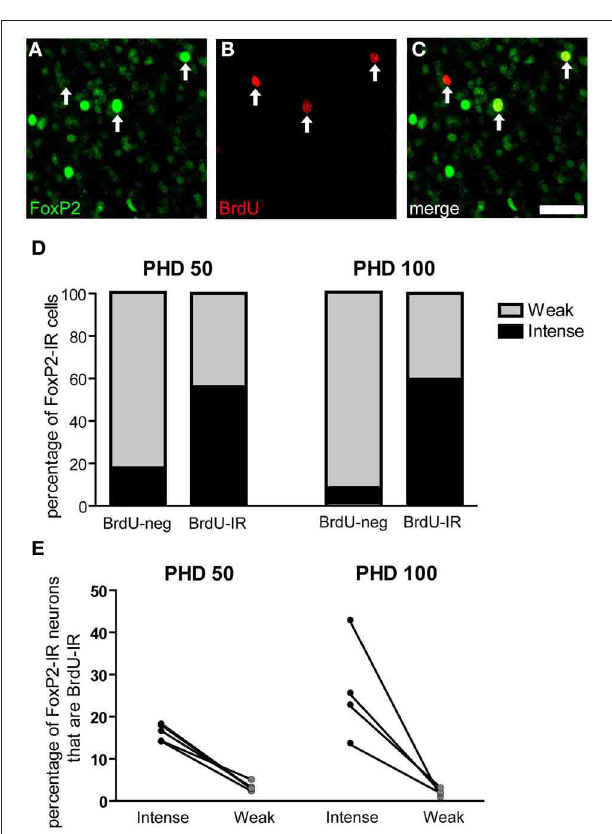
FIGURE 8 | Three-week old FoxP2-IR neurons are more likely to be intensely-stained than weakly-stained. (A–C) Photomicrographs depicting fluorescently-labeled FoxP2-IR cells (green) and BrdU-IR cells (red). Arrows indicate cells that are double labeled. Note that the cell on the left is weakly-stained for FoxP2 and the remaining two cells are intensely-stained for FoxP2. Scale bar = 50 µ m (D) In post-hatch day 50 and 100 males, BrdU-IR cells birth-dated 21 days prior to sacrifice were ∼ 60% intensely-stained for FoxP2, whereas BrdU-negative cells were much less likely to be intensely-stained for FoxP2. (E) On average, ∼ 20% of intensely-stained FoxP-IR cells were also BrdU-IR, whereas ∼ 3% of weakly-stained FoxP2-IR cells were also